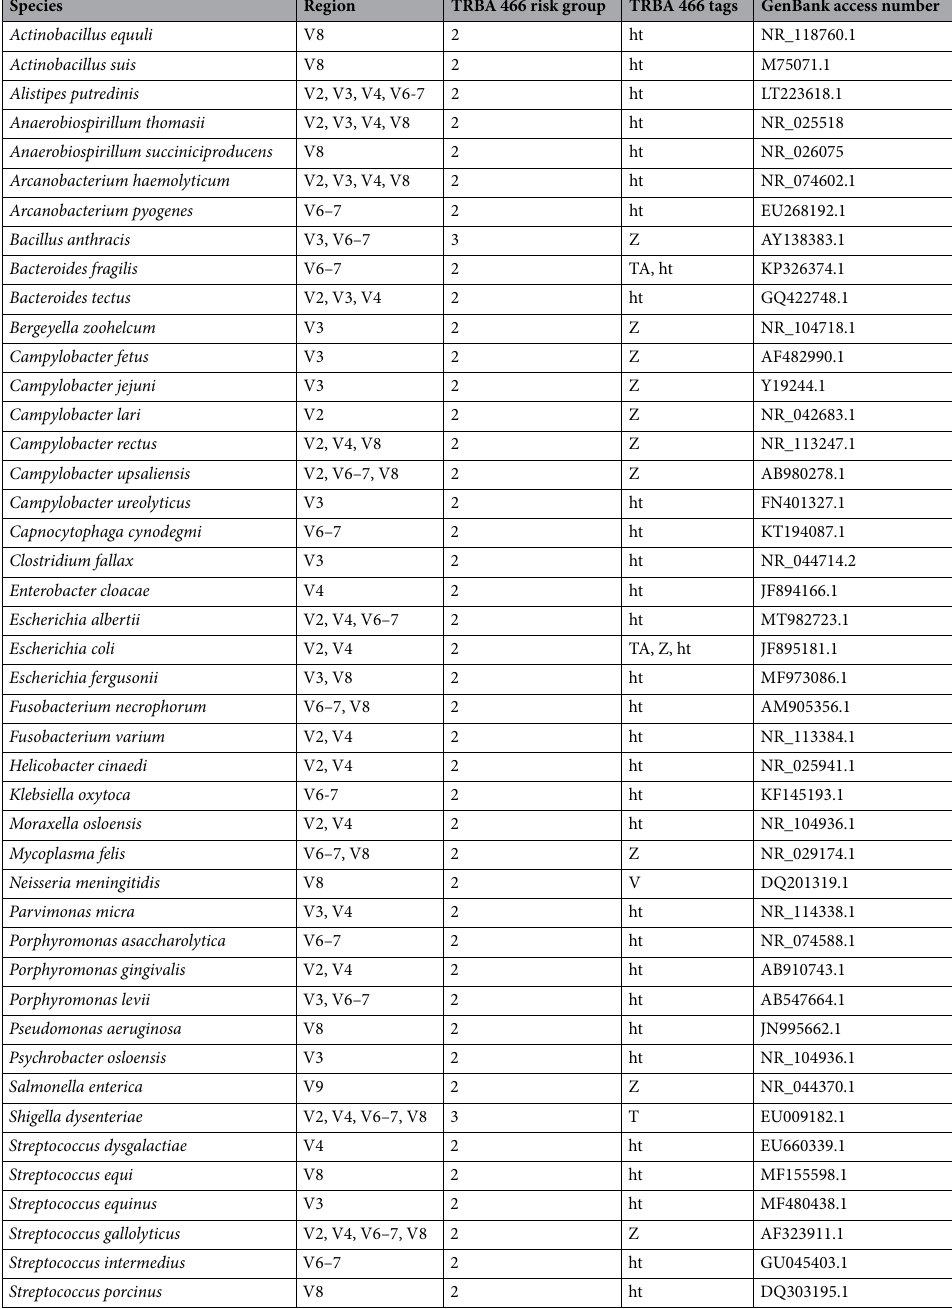
Table 1. List of detected human pathogenic bacterial species, hypervariable regions of detection, risk level groups (according to the TRBA 466prokaryotic list), and GenBank access numbers. ht pathogen for humans and vertebrates, Z zoonotic pathogen, T toxin production, TA species for which strains are known and have been handled safely, V effective vaccine